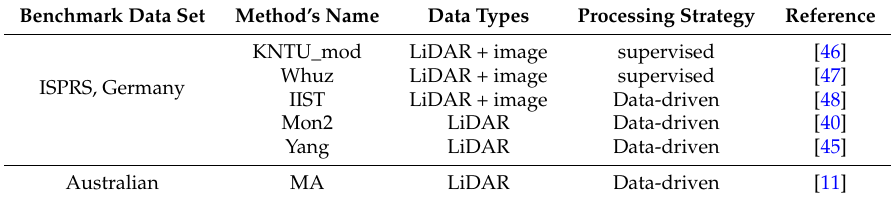
Table 6. Existing methods that have been compared with the proposed